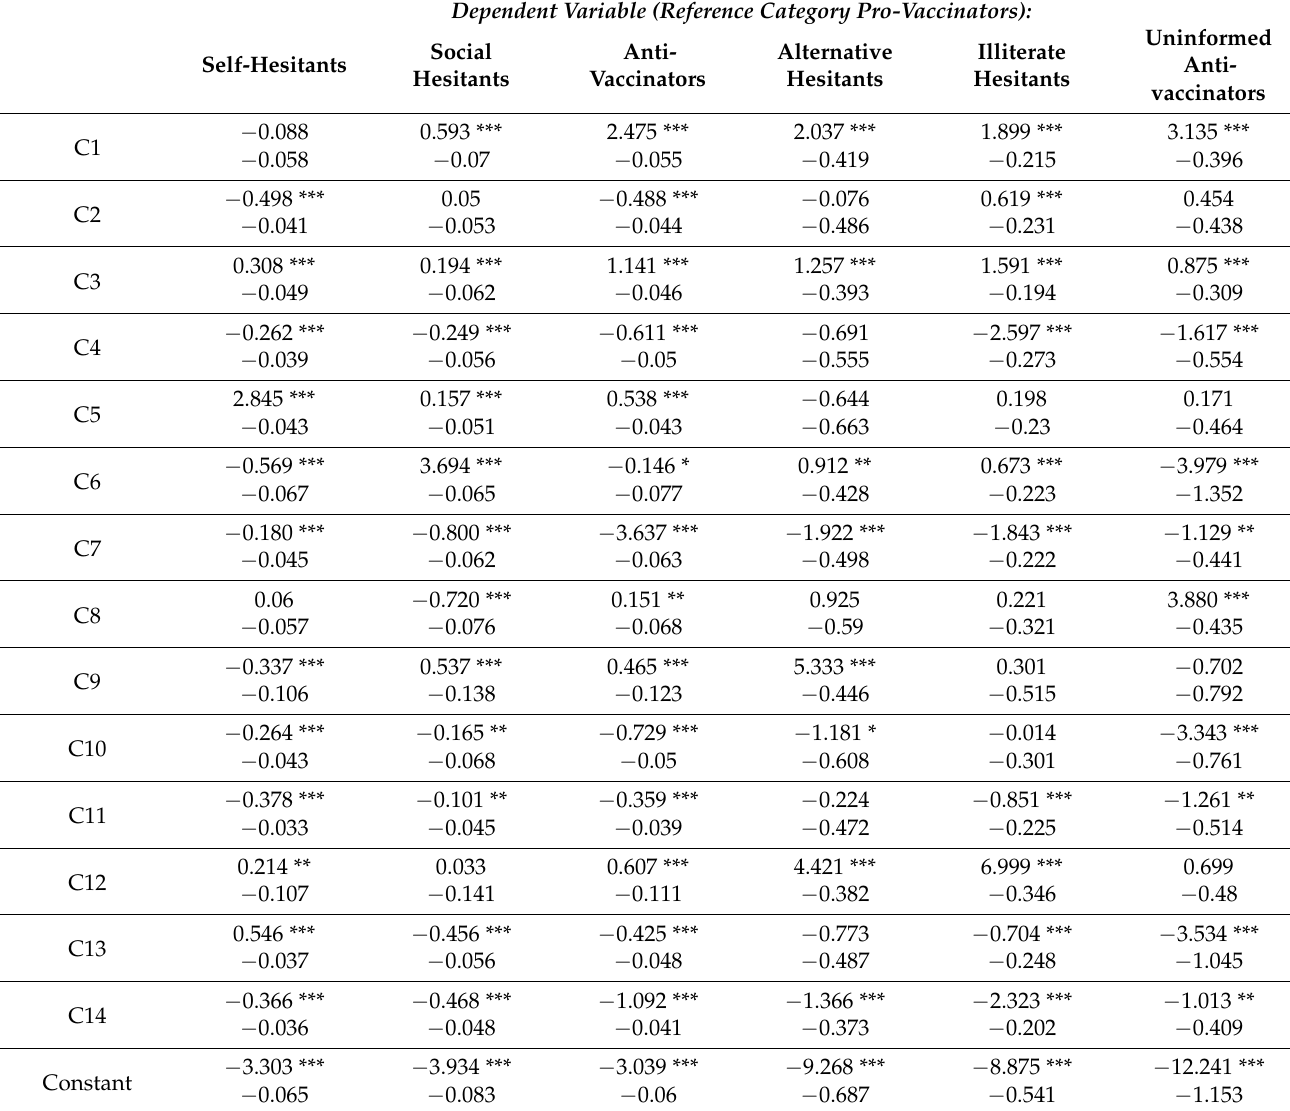
Table 4. Cross-European Segments Towards Vaccination. Multinomial Logit Model (log-odds). Dependent Variable (Reference Category Pro-Vaccinators): Social Self-Hesitants Hesitants